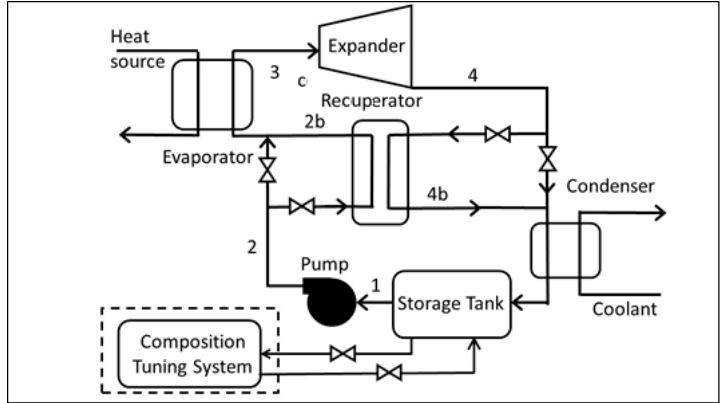
Figure 1. Schematic Diagram of Dynamic Organic Rankine Cycle considered in this paper.